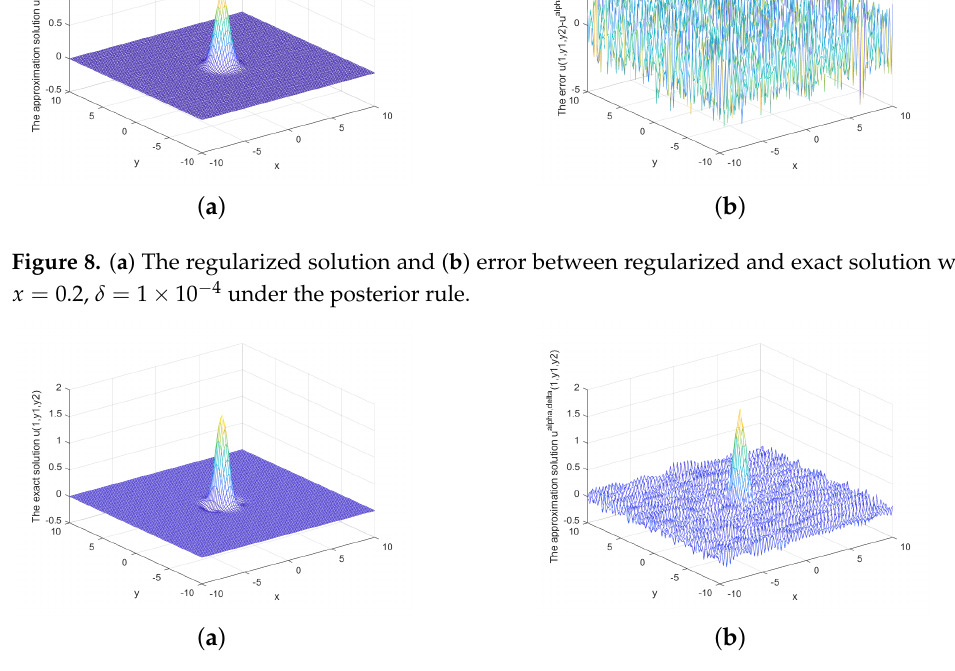
Figure 9. ( a ) The regularized solution and ( b ) error between regularized and exact solution when x = 0.5, δ = 1 × 10 − 5 under the posterior